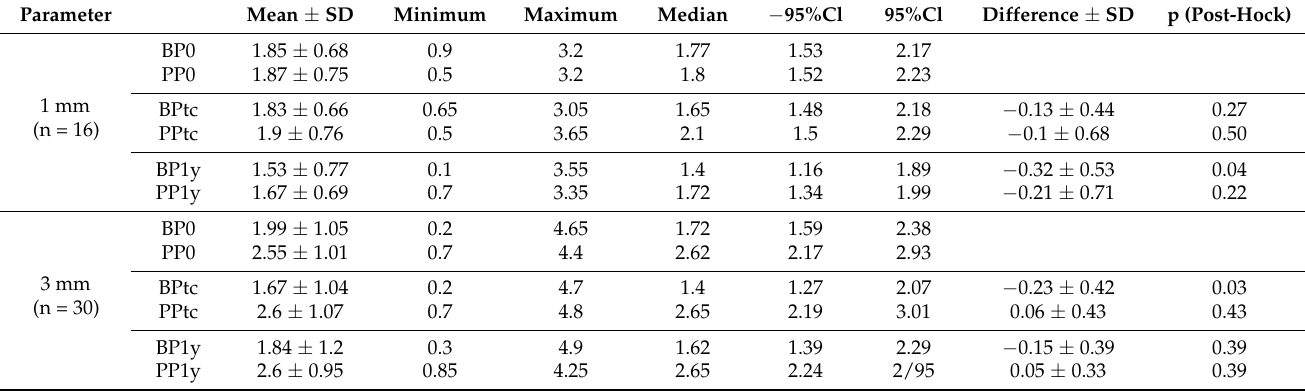
Table 1. Results of CBCT examination at relevant stages of